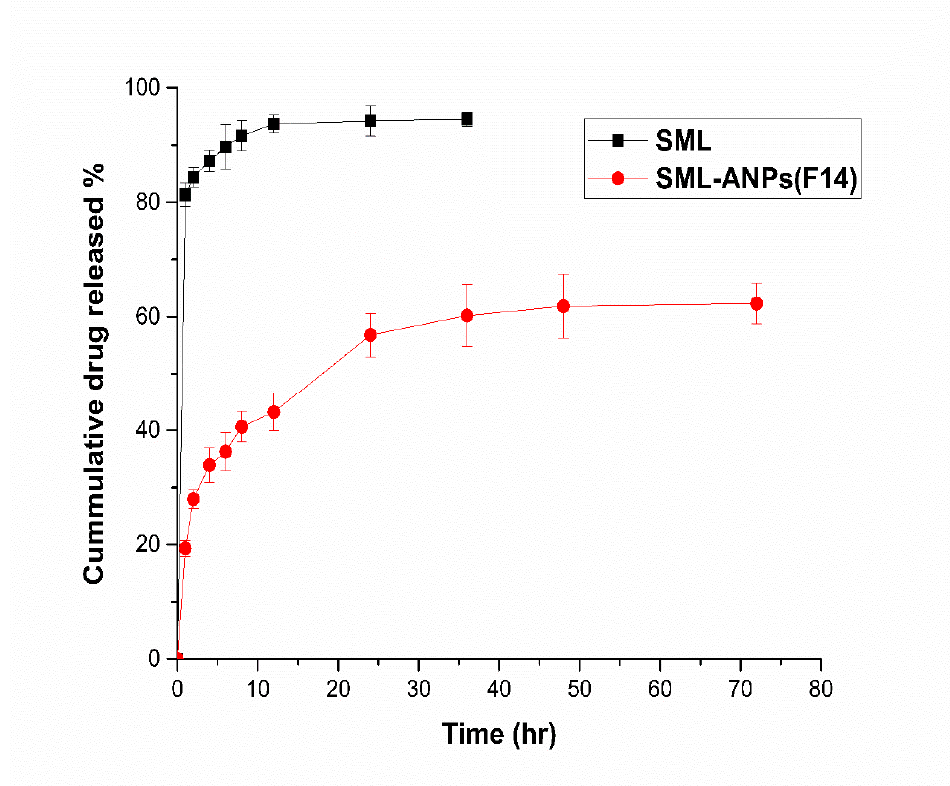
Figure 3. In vitro release profiles of free SML and SML-ANPs (F14). The values are presented as mean ± SD (n in each group = 3).